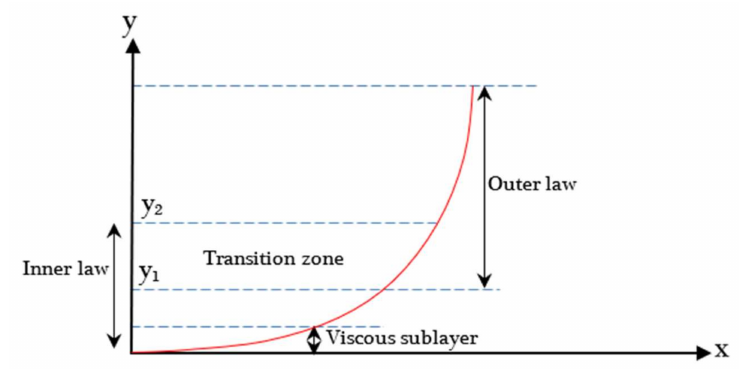
Figure 7. Regions of the inner and outer laws of the boundary layer